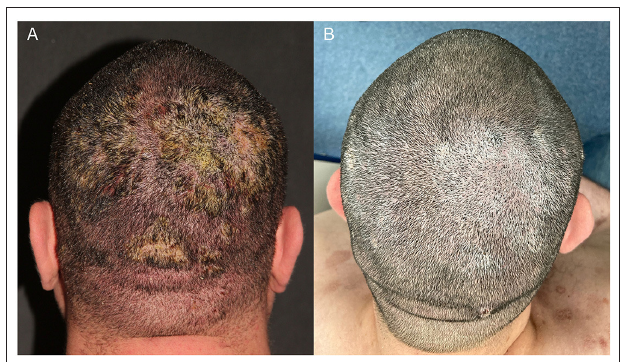
FIGURE 1 | A 36-year-old man with pemphigus vulgaris. (A) Confluent erosions with purulent crusts on the scalp in February 2021. (B) Improvement of the lesions 9 months after rituximab